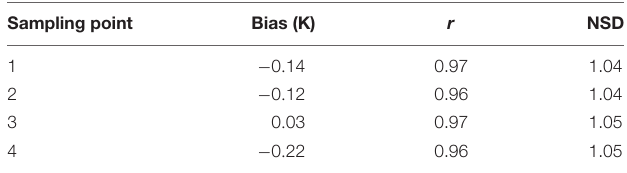
TABLE 2 | As in Table 1 for sea surface temperature (SST) and for the 1983–2017